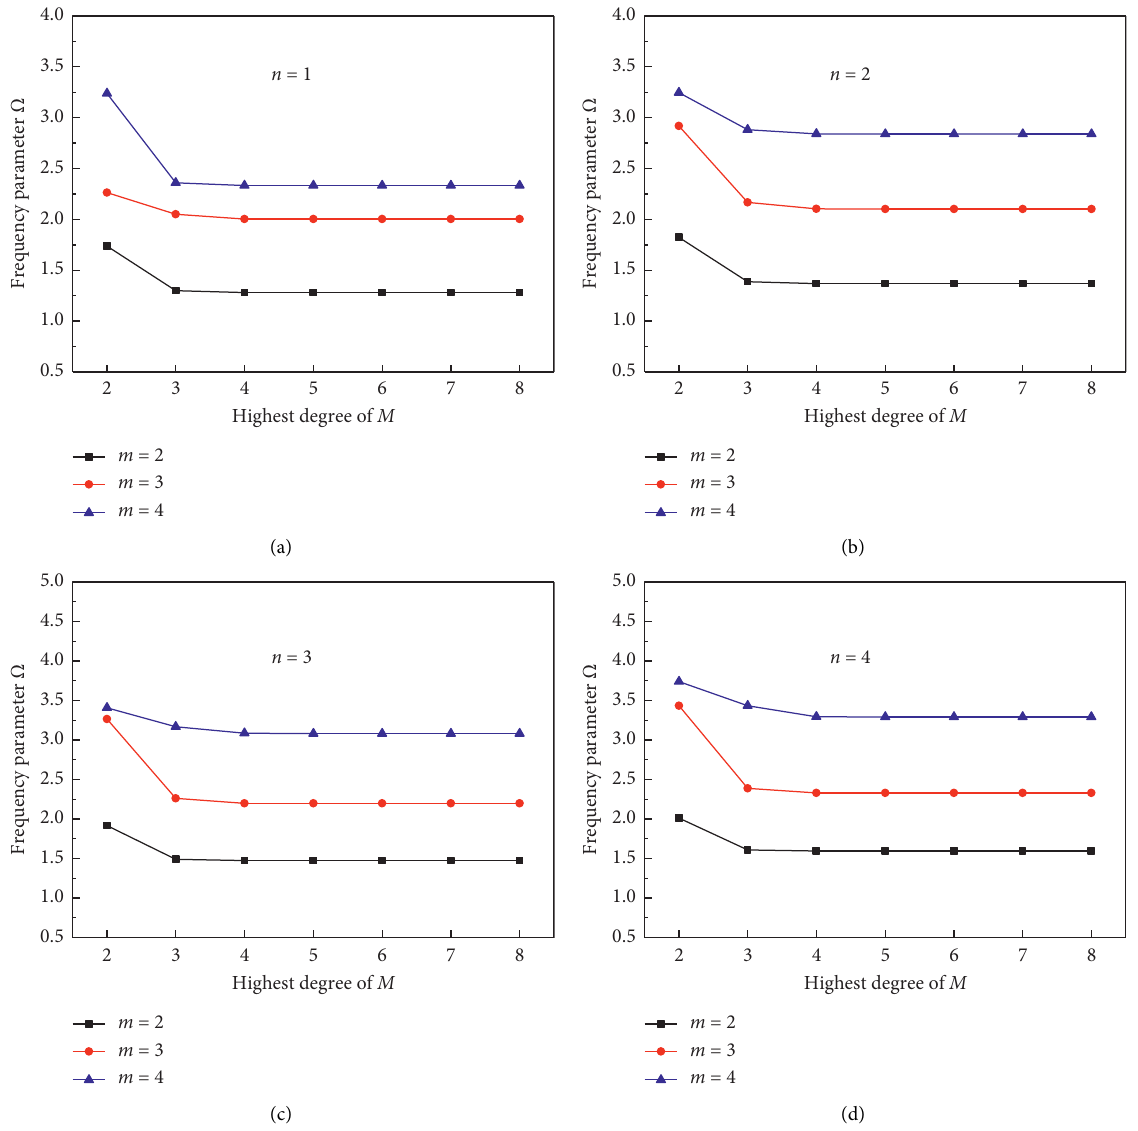
Figure 4: Frequency parameters Ω of the annular spherical shell with different truncation.